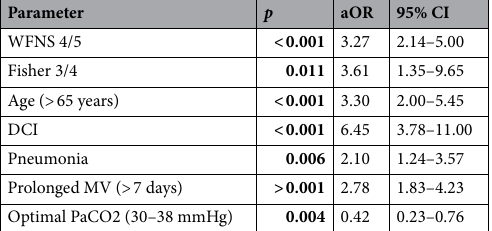
Parameter p aOR 95% CI < 0.001